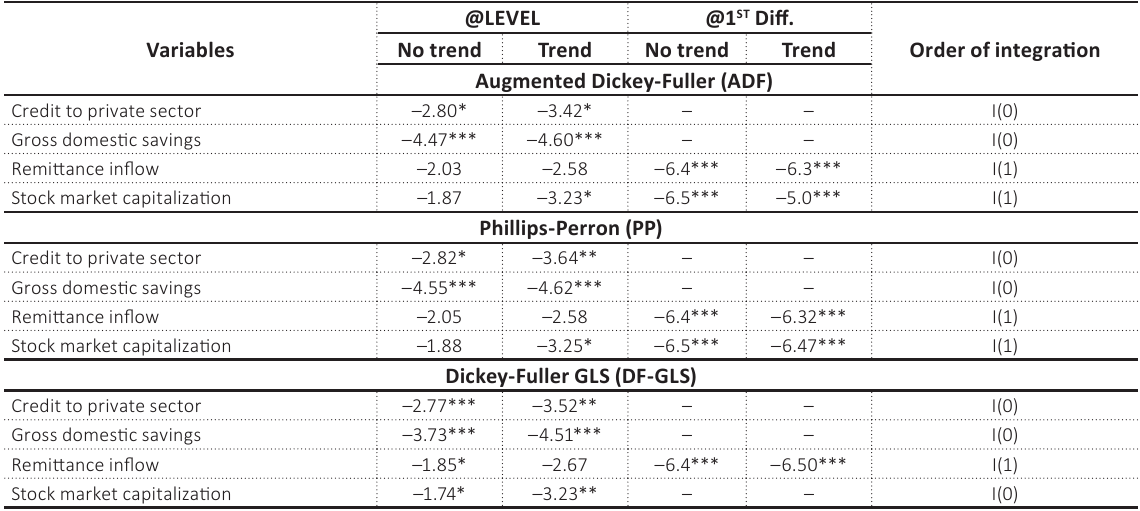
Table 2. Stationarity test